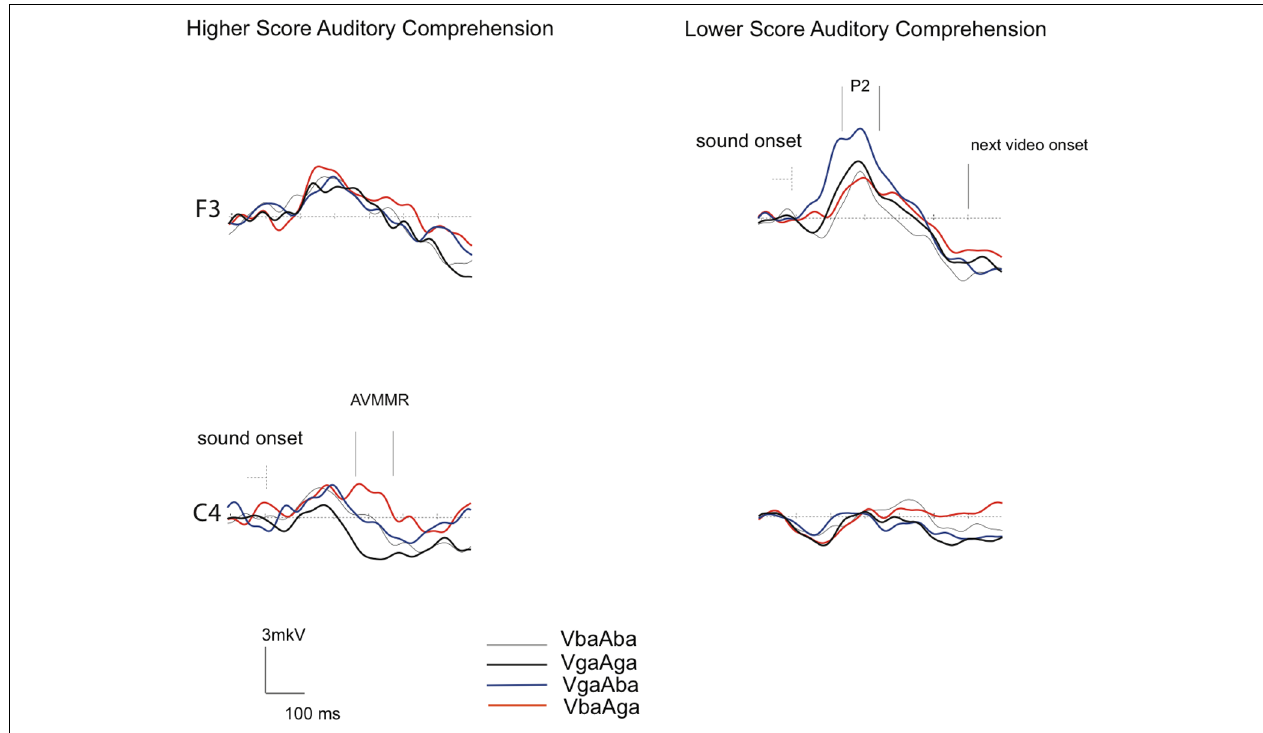
amplitude in both groups, in response to incongruent VgaAba stimuli it appears to be larger over the frontal area in infants with lower AC-PLS scores (F3 channel). In addition, although